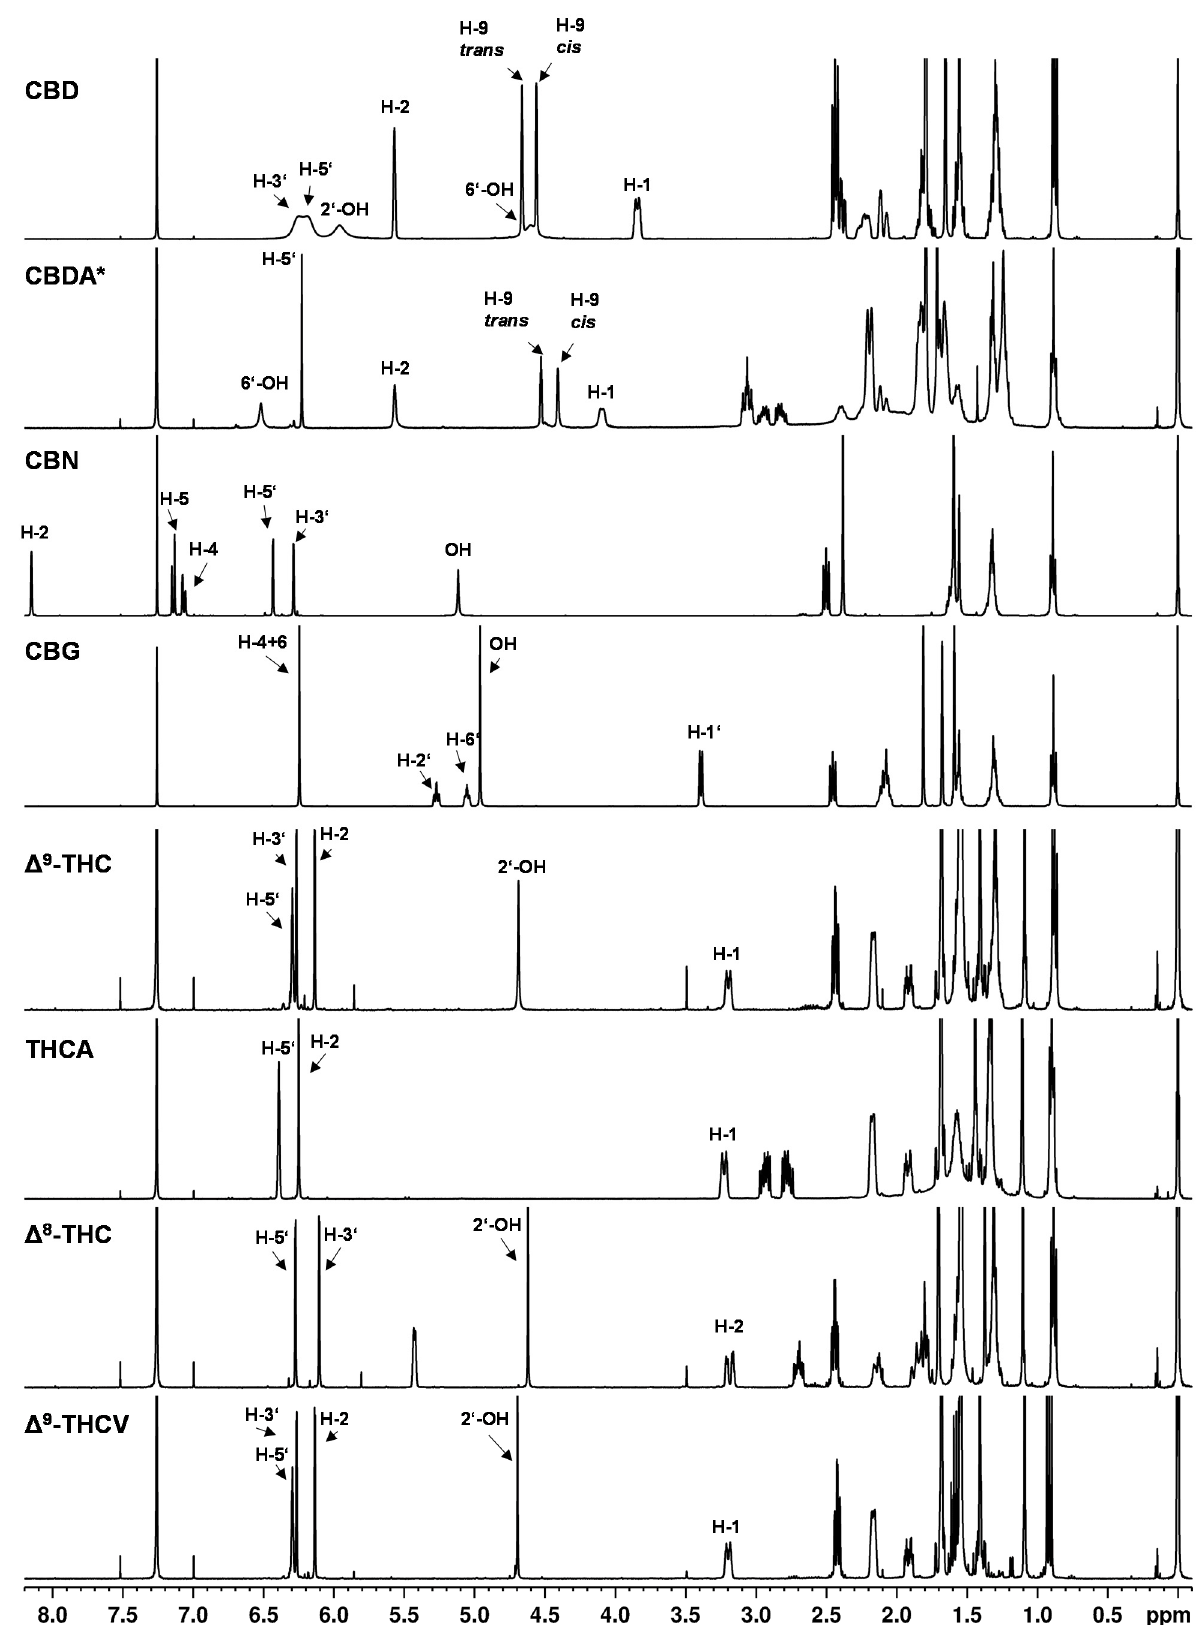
Figure 2. 1 H NMR spectra of cannabinoids CBD, CBDA, CBN, CBG, ∆ 9 -THC, THCA, ∆ 8 -THC, THCV dissolved in CDCl 3 . * Cannabinoid stabilized as N , N -dicyclohexylammonium salt.